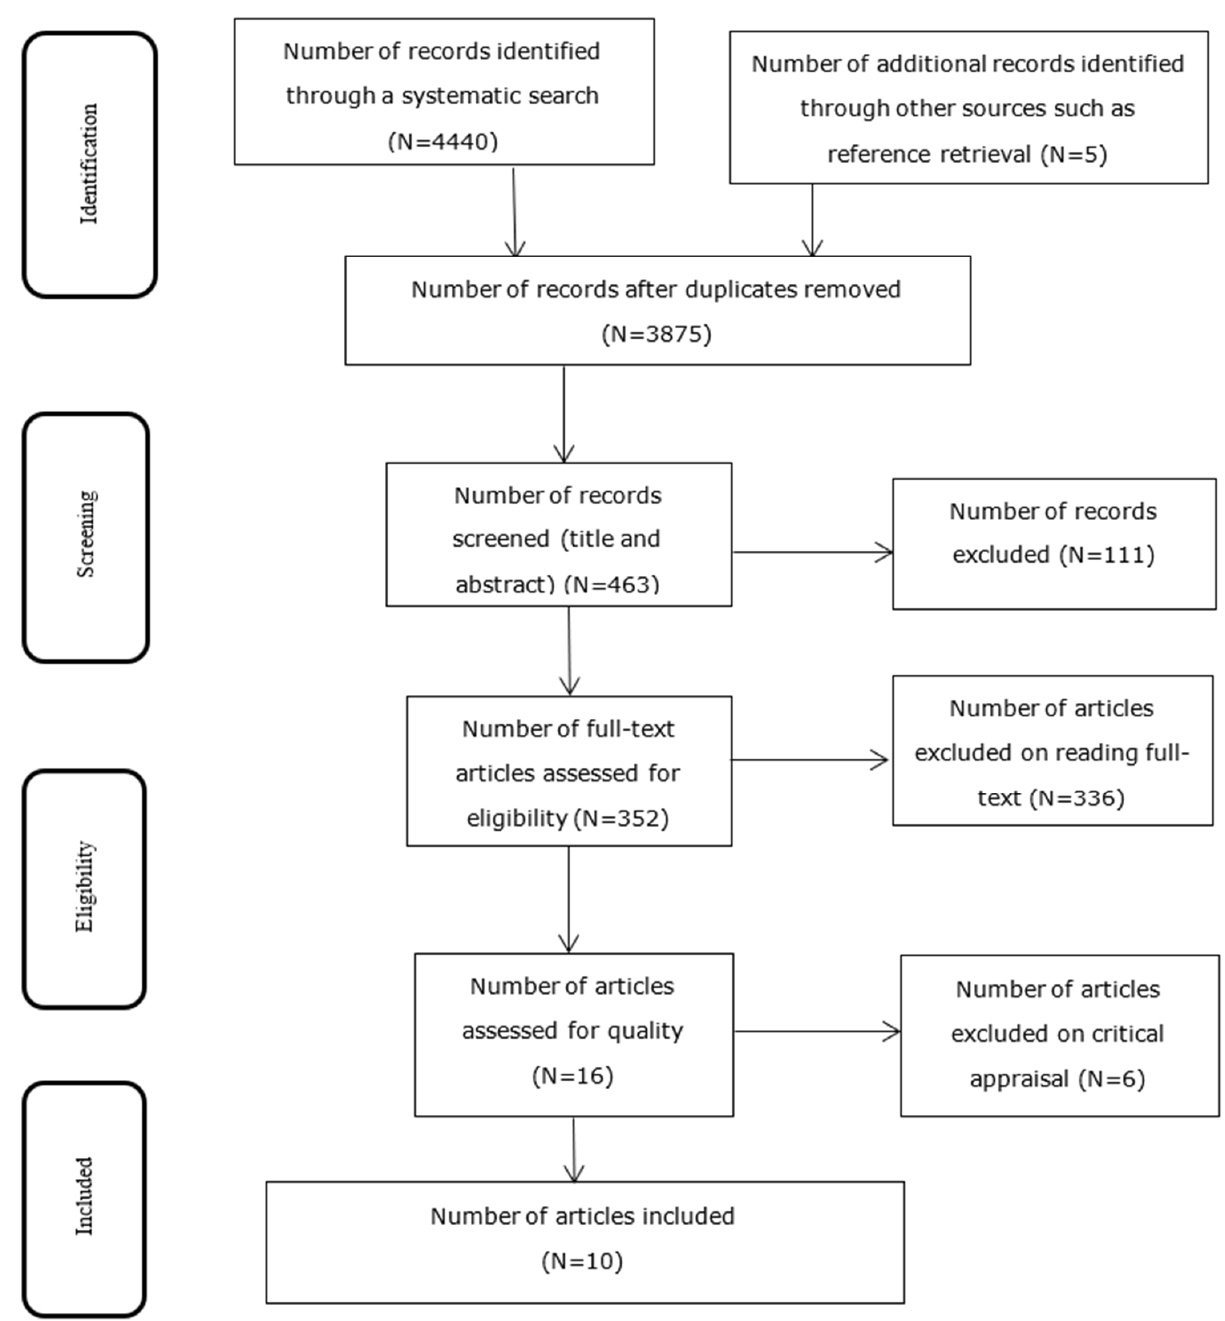
Figure 1. PRISMA flow chart diagram describing studies selected for systematic review and meta ‐ analysis of comorbidity of geo ‐ helminthes and malaria among outpatients in Ethiopia, 2020.